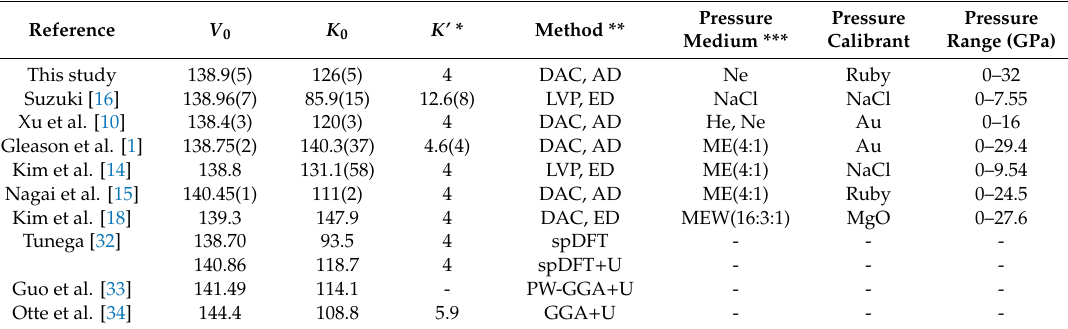
Table 2. Comparison of EOS parameters for